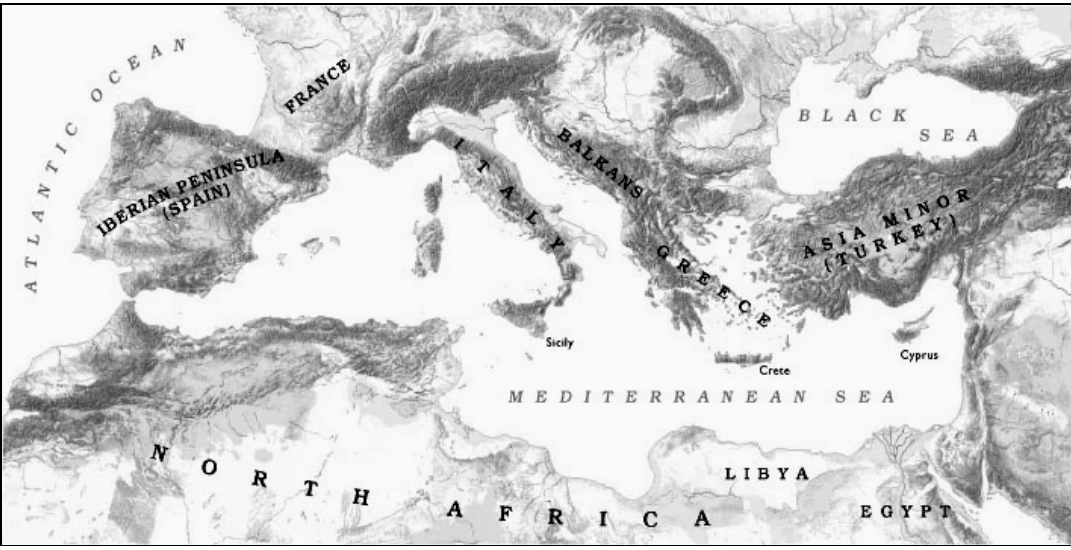
Figure1: Map of the Mediterranean Basin (IAM